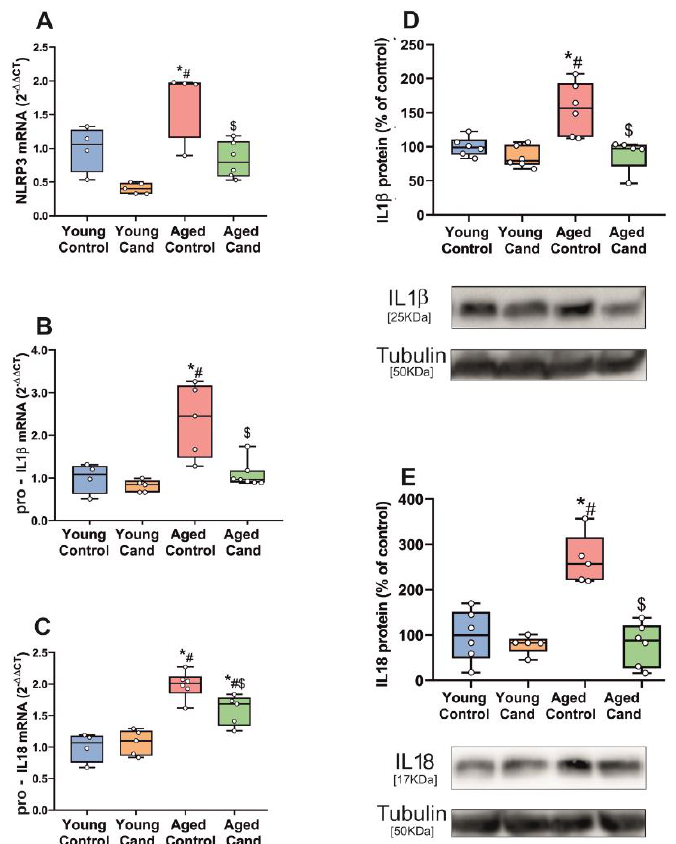
Figure 1. qRT-PCR and WB analysis of NLRP3 inflammasome markers in substantia nigra of rats. mRNA expression of NLRP3, pro-IL1 β and pro-IL18 inflammasome markers of aged rats significantly increased relative to young rats ( A – C ). Treatment of aged rats with the AT1 antagonist candesartan (Cand) significantly inhibited upregulation of the mRNA inflammasome markers ( A – C ). Protein expression of IL1 β and IL18 significantly increased in aged rats compared to young rats, which was inhibited with candesartan ( D , E ). To determine the relative mRNA expression of each gene of interest vs. the β -Actin housekeeping transcripts, we used the comparative Ct values method (2 − ∆∆ Ct ). Protein expression was determined relative to the α -tubulin band value and normalized to the control values (100%). Data distribution is shown using box plots with boxes representing the Interquartile range (IQR) and the median and whiskers representing the maximum value (upper whisker) and the minimum (lower whisker). * p < 0.05 relative to young control rats; # p < 0.05 relative to young rats + candesartan, $ p < 0.05 relative to aged control rats.